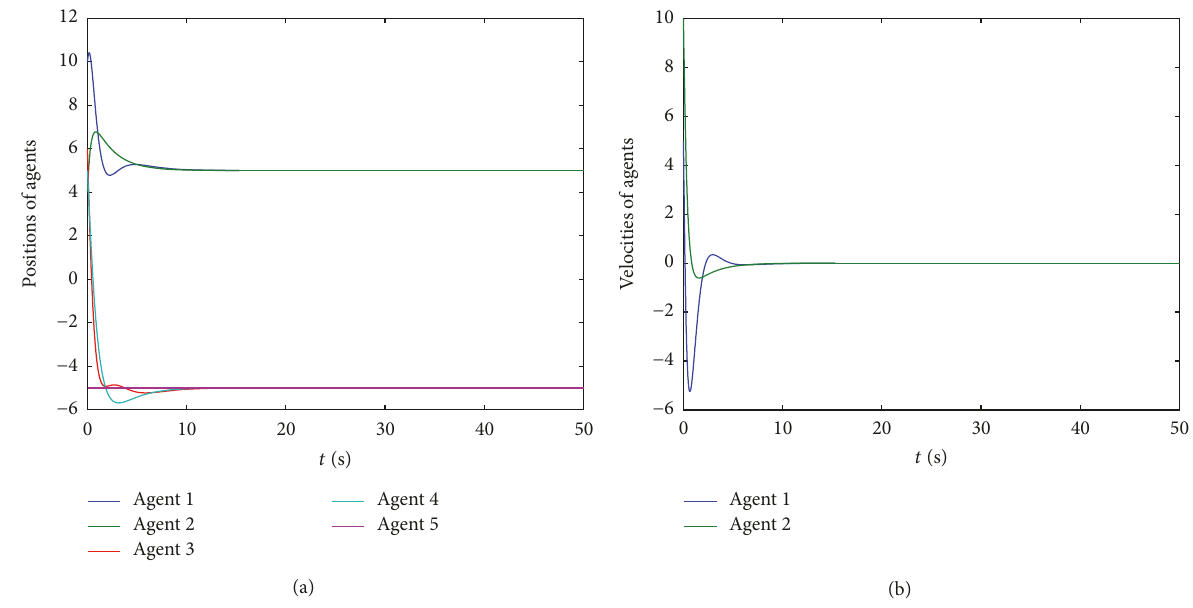
Figure 8: The state trajectories of the agents in systems (18) when 𝜏 = 0.1 s. (a) Position state and (b) velocity